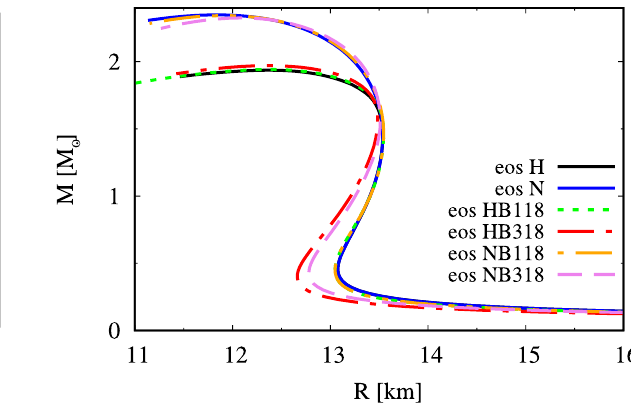
Fig. 1 EOS obtained with nucleons only (labeled N) and with the baryon octet (labeled H) for non-magnetized matter and with B 0 equal to 1 . 0 × 10 18 G (labeled B118) and 3 . 0 × 10 18 G (labeled B318)